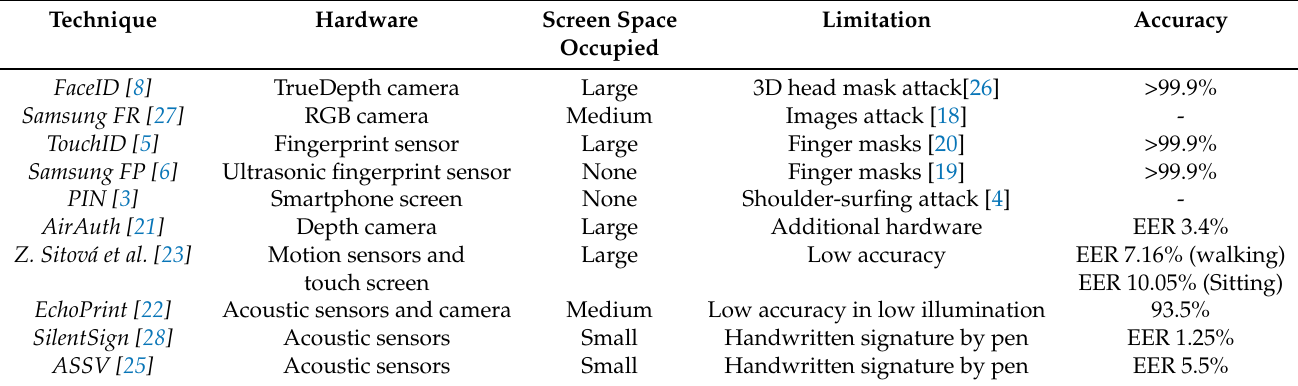
Table 3. Summary of existing smartphone authentication